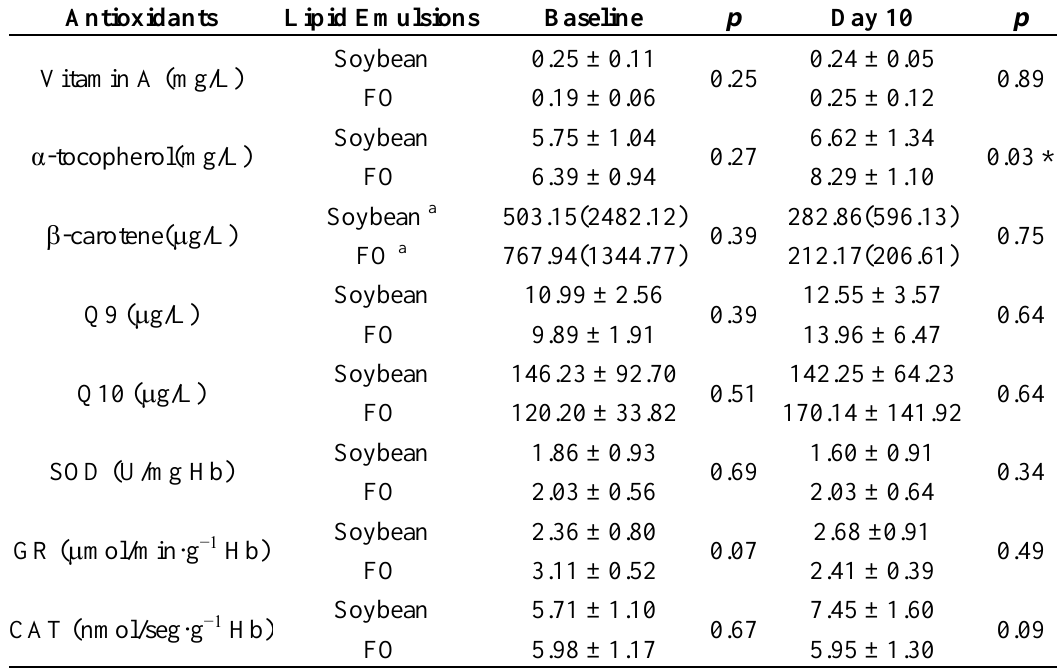
Table 2. Comparison between blood antioxidant levels in two groups of patients undergoing hematopoietic stem cell transplantation with parenteral nutrition based on soybean- or FO- containing lipid emulsion, at the beginning (baseline) and at day 10 of parenteral